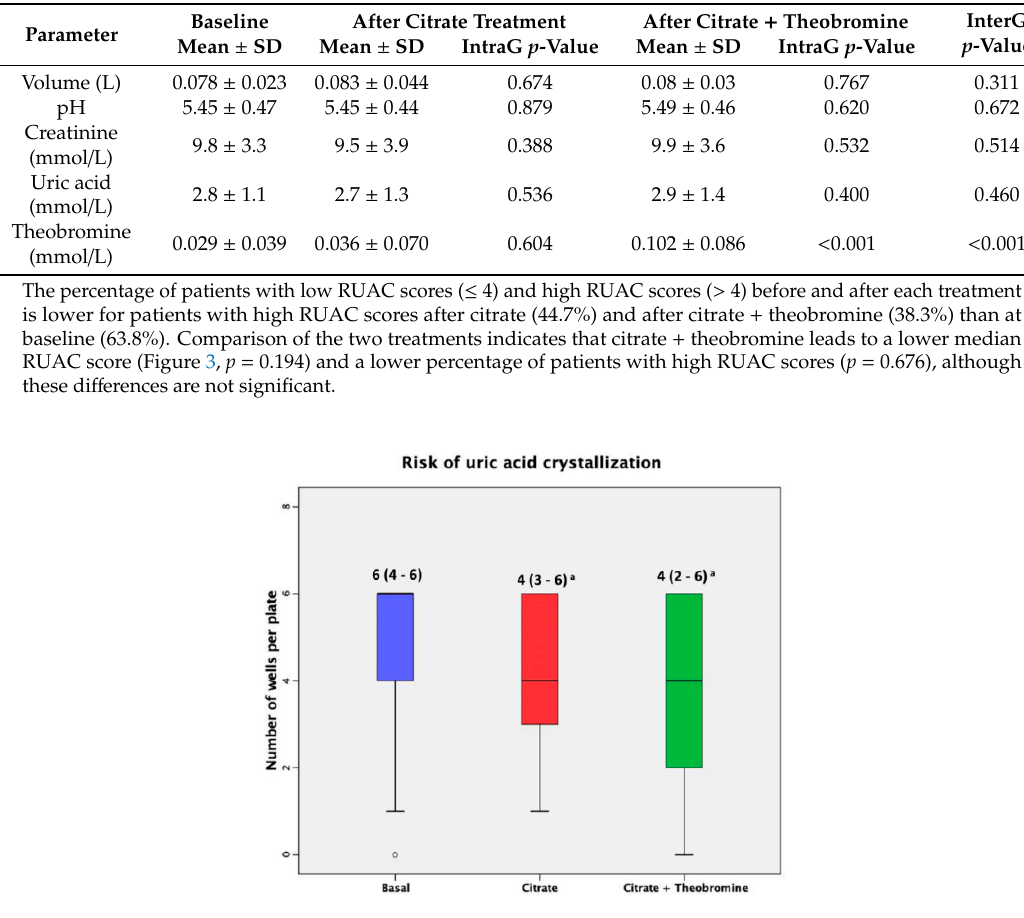
Figure 3. Risk of crystallization of uric acid at baseline and after both treatments. Median (interquartile ranges) of the number of crystallized wells before and after both dietary interventions. The dark lines in the boxes are the medians. The bottom and the top of the box indicate the 25th and the 75th percentiles, respectively. These values are indicated on each box. The T-bars that extend from the boxes are the inner fences. The point is an outlier. (a) p < 0.001 vs. basal value.